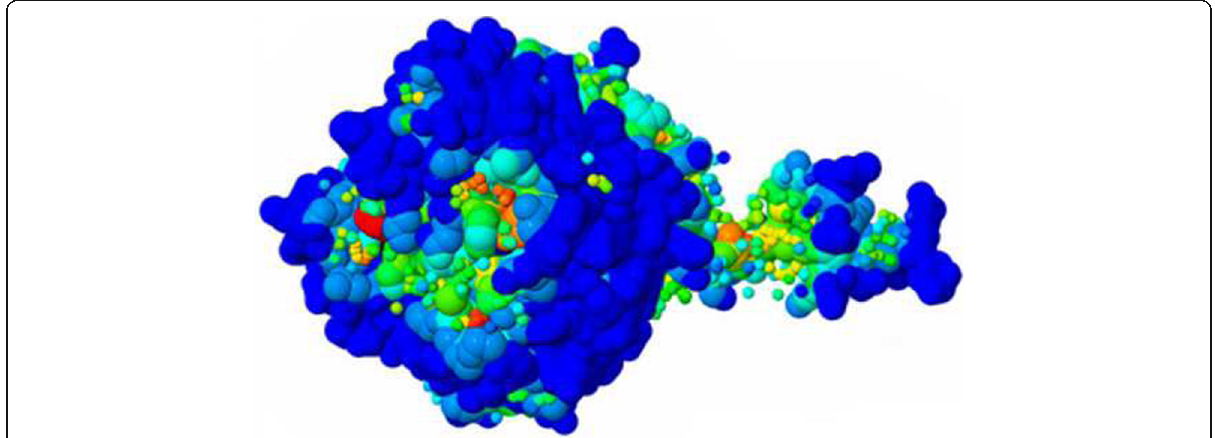
Fig. 8 GHECOM results, Jmol view of pocket structure based on pocketness